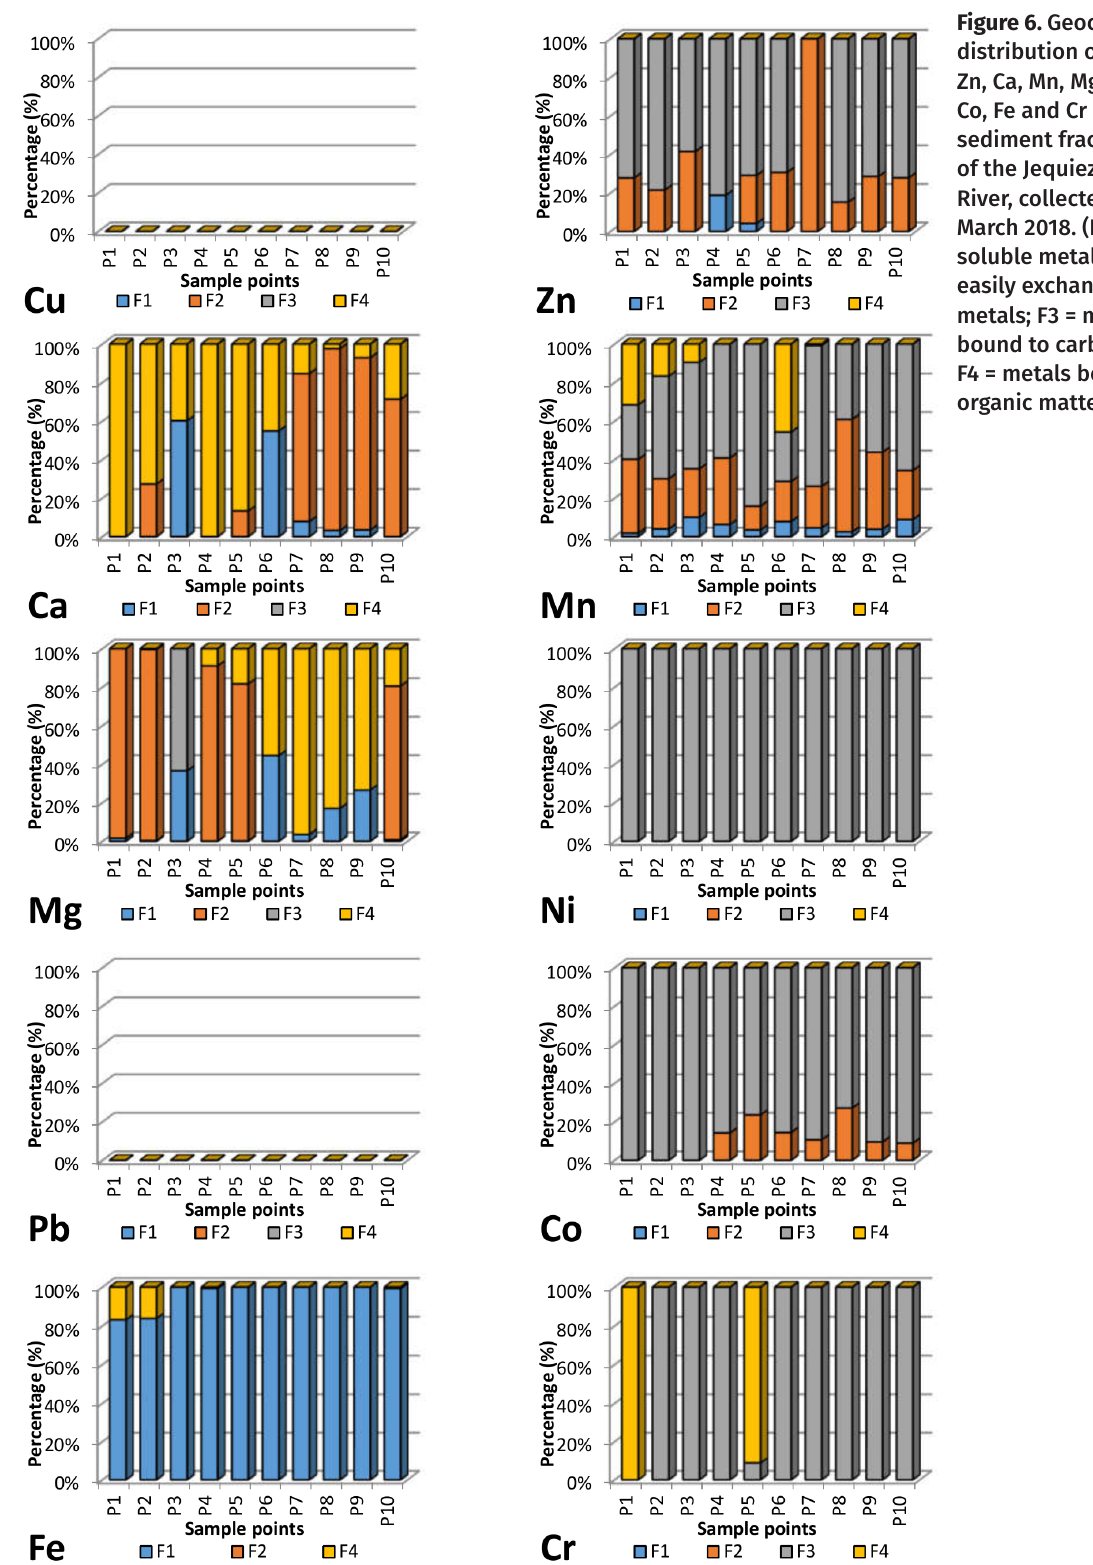
Figure 6. Geochemical distribution of Cu, Zn, Ca, Mn, Mg, Ni, Pb, Co, Fe and Cr in the sediment fractions of the Jequiezinho River, collected in March 2018. (F1 = soluble metal; F2 = easily exchangeable metals; F3 = metals bound to carbonates; F4 = metals bound to organic